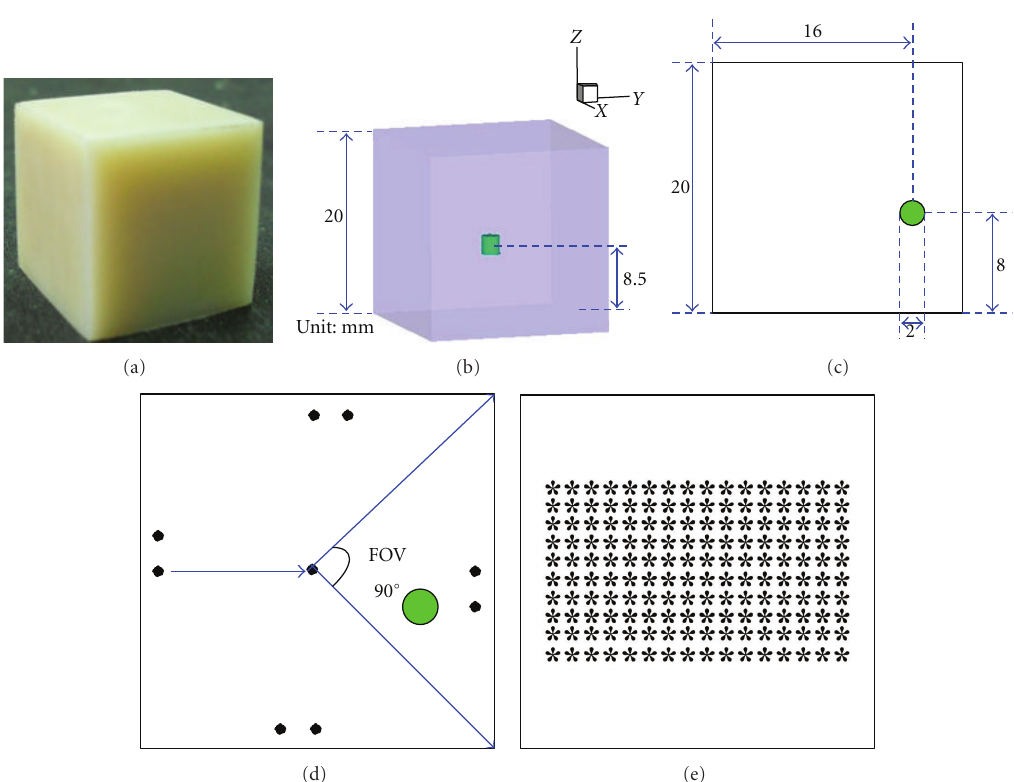
Figure 6: The setup for the physical phantom experiment. (a) The photography of the phantom. (b) The location of the single fluorophore in the phantom. (c) The middle cross-section of the phantom. (d) The point excitation sources in each faces of the phantom with a 90 ◦ field of view (FOV). (e) There were 160 detectors recording the transmitted light in the 90 ◦ (FOV) for each excitation